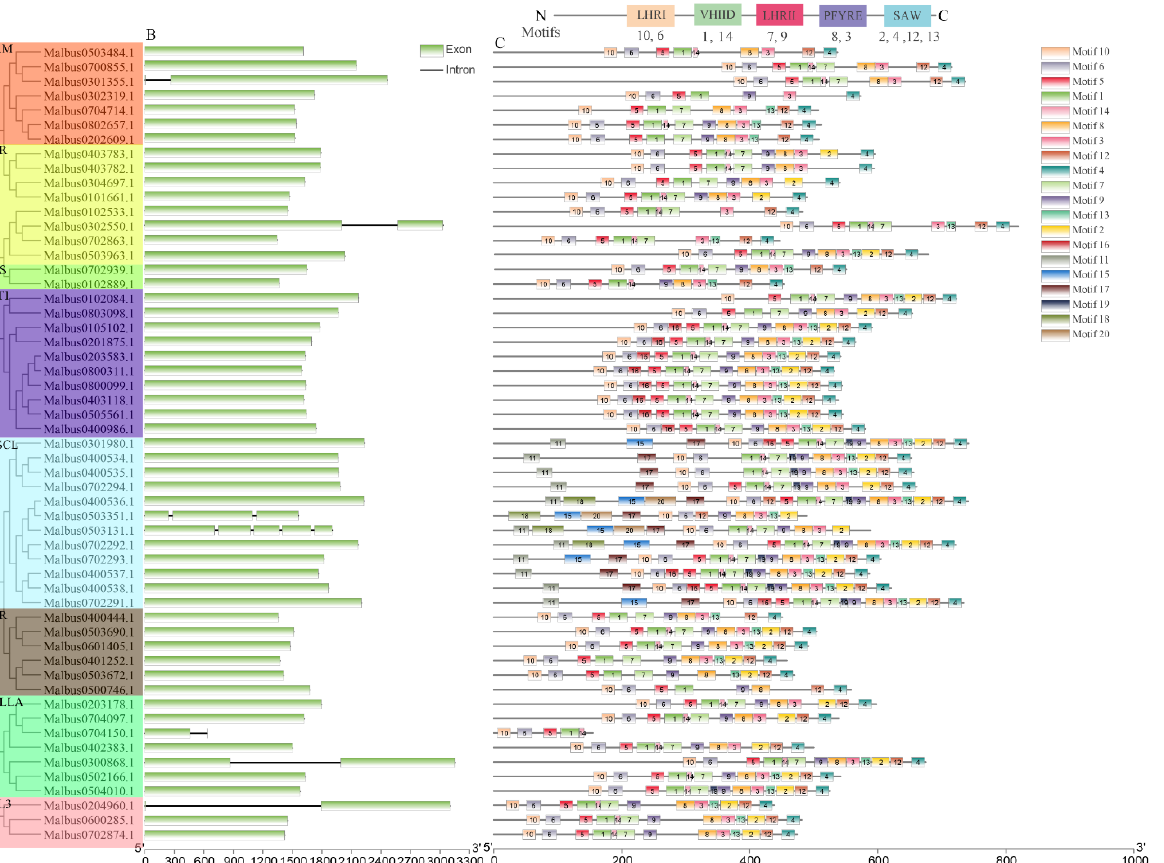
Figure 4. Exon–intron structure and distribution of conserved motifs of MaGRAS genes in M. albus : ( A ), MaGRAS proteins are categorized into 8 subfamilies, which are classified and labeled with different colors, including LISCL, SHR, PAT1, LAS, HAM, DELLA, SCR, and SCL3; ( B ), exon–intron structures of MaGRAS genes. Intron indicated by black line and CDS exon indicated by green boxes; ( C ), schematic diagram of the conserved motifs in the MaGRAS proteins. Each motif is represented by a number in the colored box. The black lines represent the non–conserved sequences. A total of 5 conserved domains and corresponding motifs in the GRAS proteins sequences are shown at the top. A scale of gene and protein length is shown at the bottom.